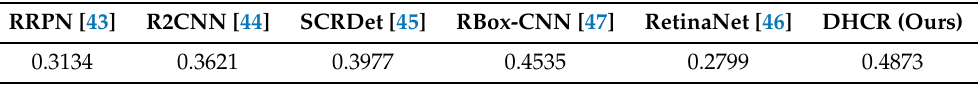
Table 5. Comparison of running times (sec/patch) for the time complexity analysis. We evaluated the running times on a patch image sized 768 × 768 with a Titan Xp GPU.